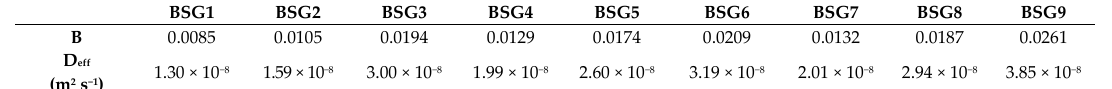
Table 2. Slope and effective diffusivity.